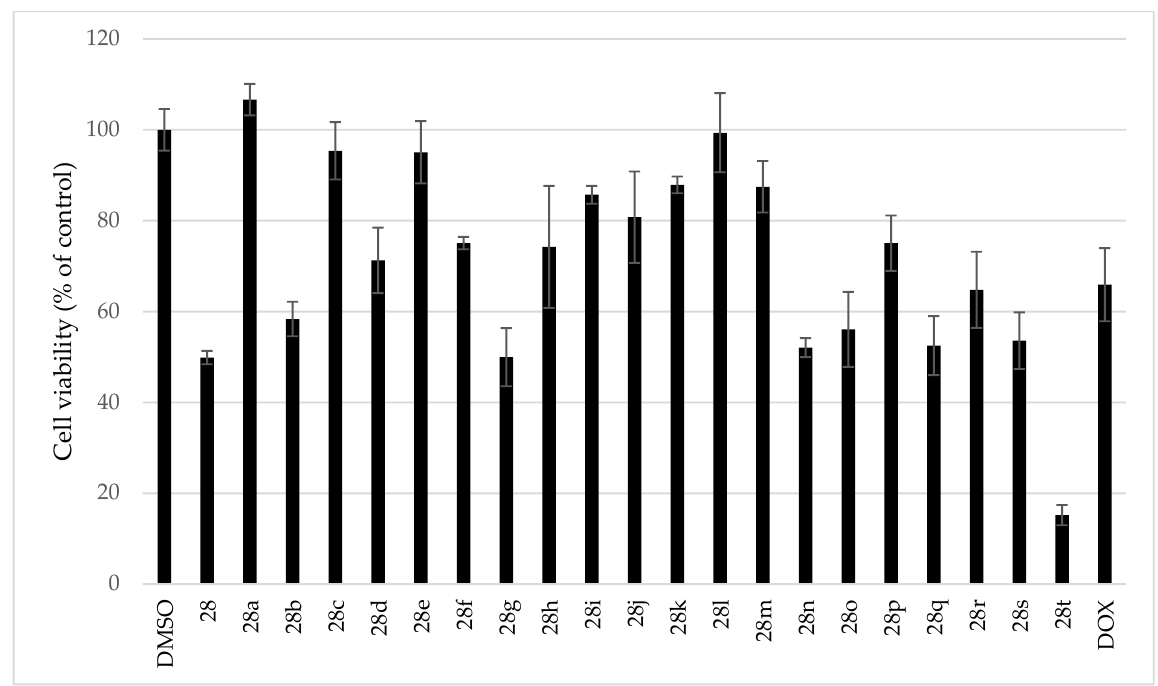
Figure 8 . Screening of cytotoxic potential of ambelline derivatives at 10 μM concentration on HepG2 Figure 8. Screening of cytotoxic potential of ambelline derivatives at 10 µ M concentration on HepG2 cell line. cell